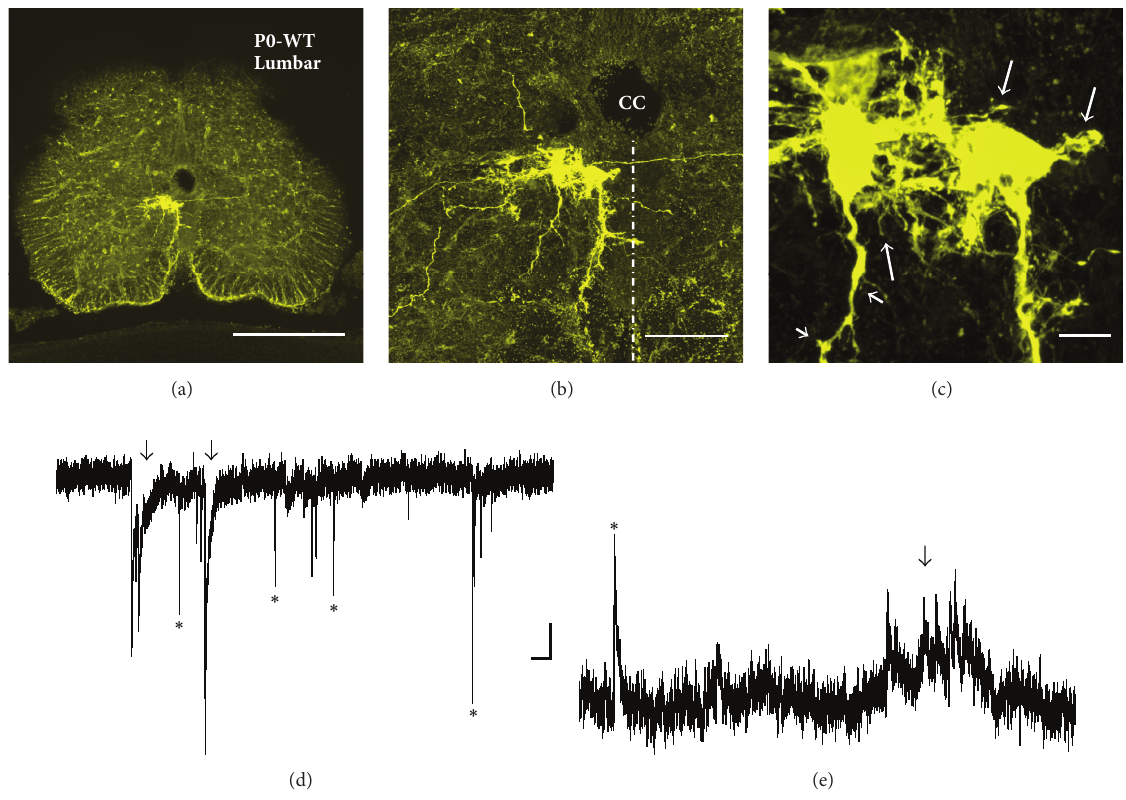
Figure 2: The somatodendritic and synaptic properties of lumbar motoneurons from a newborn wild-type C57/Bl6 (P0-WT) mouse. (a) Low- power image showing a lumbar spinal cord slice in transverse plane and the location of dye-filled motoneurons (yellow cells). (b) Medium- power confocal image showing two dye-coupled motoneurons located ventrolateral to the central canal (CC), with commissural dendrites crossingthemidline(dashed line) tothecontralateral sideof thespinalcord. (c)High-power confocal image of thesetwo motoneurons, which displayed action potential firing upon membrane depolarization (not shown), each displaying extensive filopodia (long arrows) and spine-like processes (short arrows) present in their somatodendritic domains. (d) Excitatory postsynaptic currents (downward deflections) recorded at a holding potential of − 60mV. Fast inactivating excitatory currents may be AMPA receptor-mediated (asterisks), whereas slowly inactivating excitatory currents likely include NMDA currents alone or together with AMPA (short arrows). (e) Inhibitory postsynaptic currents (upward deflections) recorded at a holding potential of 0mV. Fast inactivating inhibitory currents may be glycine-mediated (asterisk), whereas slowly inactivating currents likely include GABA-mediated currents (short arrows). Scale bar is 200 𝜇 m in (a), 50 𝜇 m in (b), and 10 𝜇 m in (c). Scale bars for (d and e) are 250 ms and 25